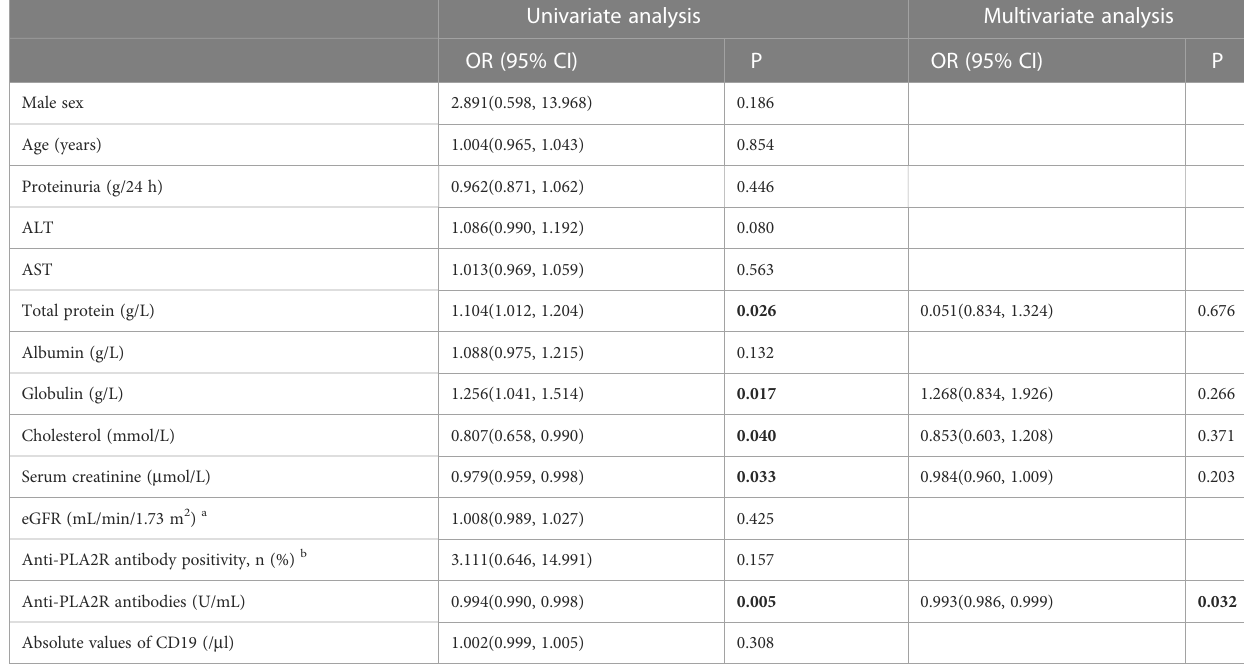
TABLE 5 Risk factors for nonremission in patients with PMN receiving rituximab therapy (logistic regression).